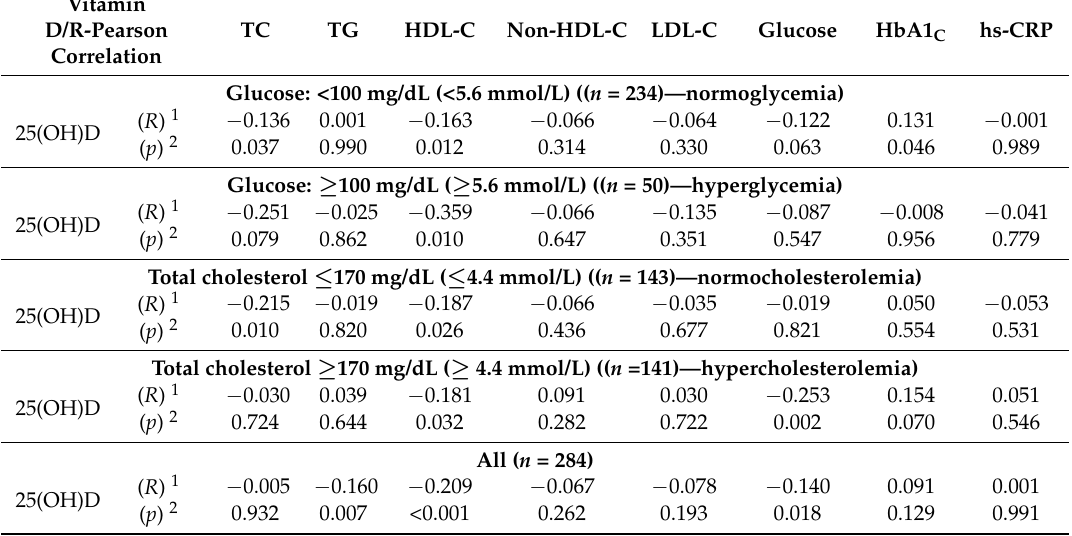
Table 3. Pearson’s correlation coefficients in normo-/hyperglycemic and normo-/hypercholesterolemic state. Vitamin D/R-Pearson